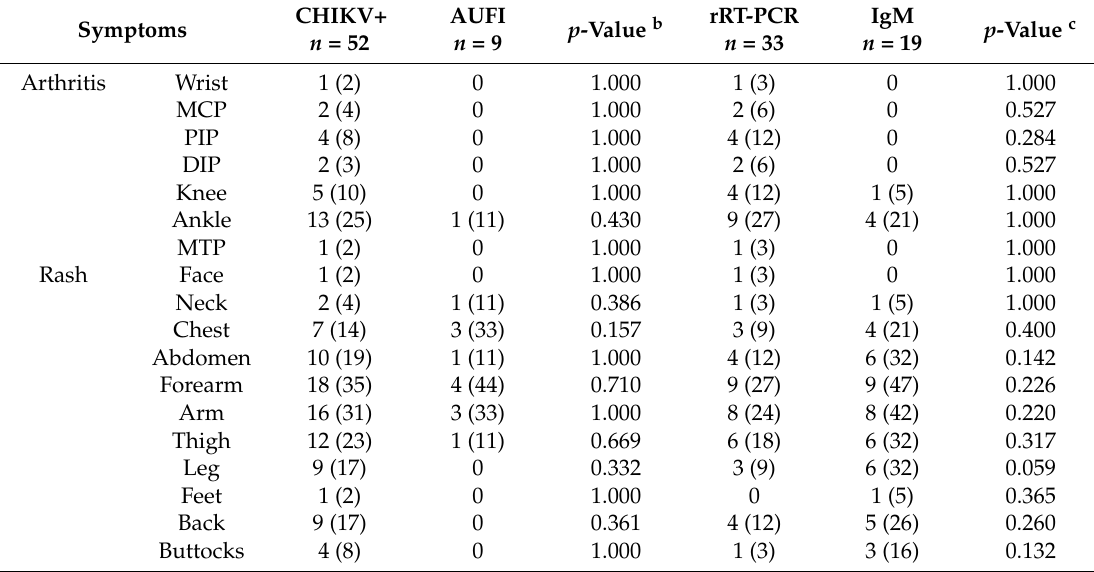
Table 2. Arthritis and Rash distribution of the studied patients in Tapachula, Chiapas, June through July 2015 a